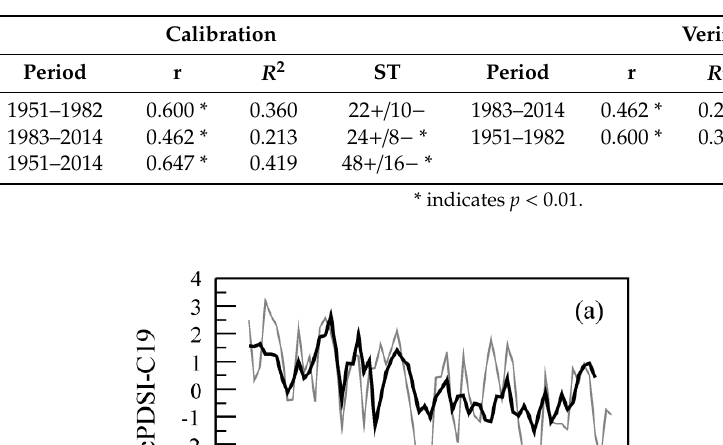
Table 3. Statistical features of split calibration–verification for the January–September mean scPDSI reconstruction model.